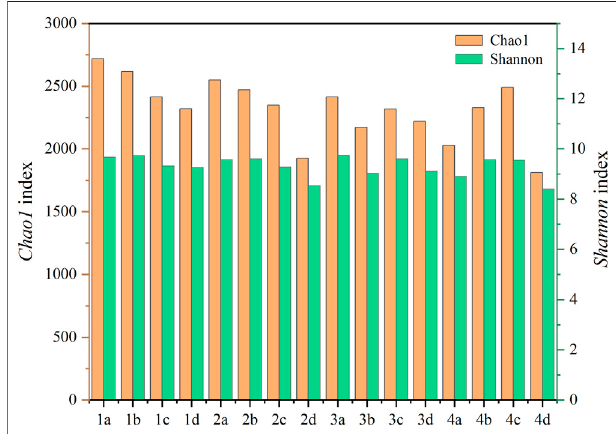
FIGURE 5 | The alpha diversity indices of the soil bacterial 16S rRNA gene.Letters a,b,c,and drepresent0%,0.2%, 0.5%, and 1%NMMT added in Cd-contaminated soil, respectively.